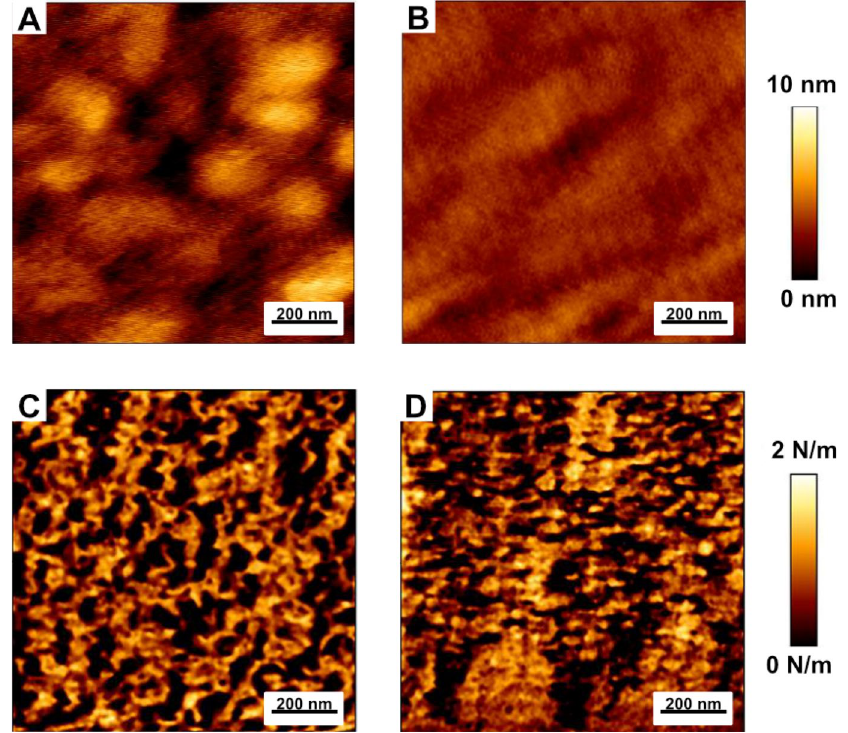
Figure 2. Zinc ion binding influence on the morphology and the stiffens of the layer: AFM topography analysis of ( A ) HDT-Dd-OT (Ra = 1.05 ± 0.09 nm) and ( B ) HDT-Dd-OT-Zn 2+ (Ra = 0.52 ± 0.05 nm) and Slope of force- distance images of ( C ) HDT-Dd-OT and ( D ) HDT-Dd-OT-Zn 2+